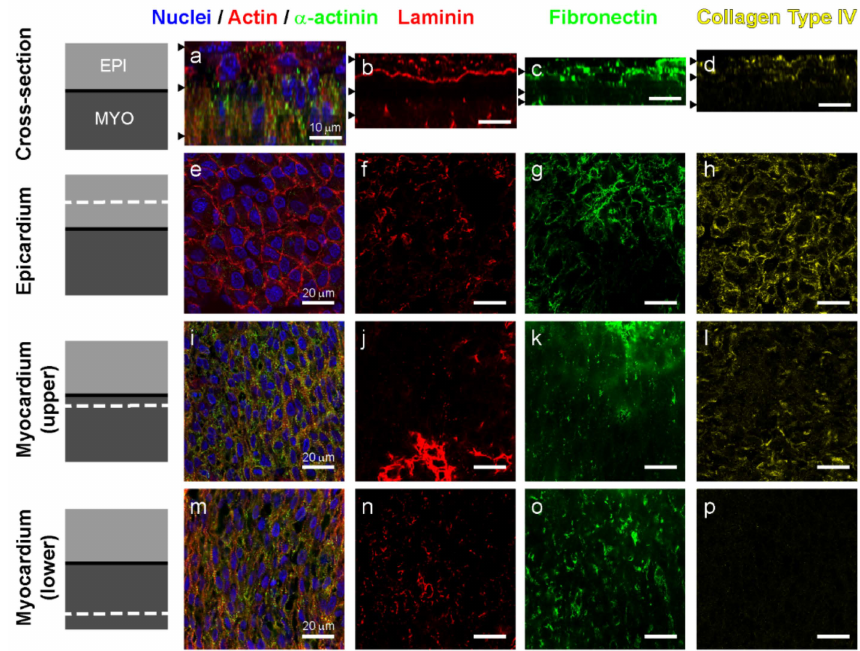
Figure 3. Structure and localization of fibronectin, laminin, and collagen type IV in the epicardium and compacted myocardium of the left ventricle at day 5. ( a – d ) Cross-sections of 3D z-stacks with black arrowheads marking the location of each slice for ( e – h ), ( i – l ), and ( m – p ) from top to bottom. ( a ) Cross-section of a 3D confocal z-stack showing the epicardium ( α -actinin negative) and the underlying myocardium ( α -actinin positive–green). ( b – d ) Cross-sections of 3D images showing respectively laminin, fibronectin, and collagen type IV. ( e ) A single image of the epicardium showing polygonal shaped cells cortical actin at the borders of the epithelial cells. ( f – h ) The epicardium has laminin, fibronectin, and collagen type IV throughout. ( i ) In the upper myocardium, just below the epicardium, aligned cardiomyocytes are visible and express α -actinin. ( j – l ) The laminin and collagen type IV are decreased compared to the epicardium, while fibronectin is also reduced but fibers are clearly aligned in direction of the cardioymocytes. Note that laminin staining in ( j ) is due to an artifact of the Z-section including a region of basement membrane. ( m ) In the deeper myocardium, just above the trabeculations, aligned cardiomyocytes are visible as well as some empty spaces. ( n – p ) The laminin in this region is further decreased but the collagen type IV is entirely absent, and the fibronectin actually increases and is aligned. Scale bars are 10 µ m for ( a – d ) and 20 µ m for ( e – p